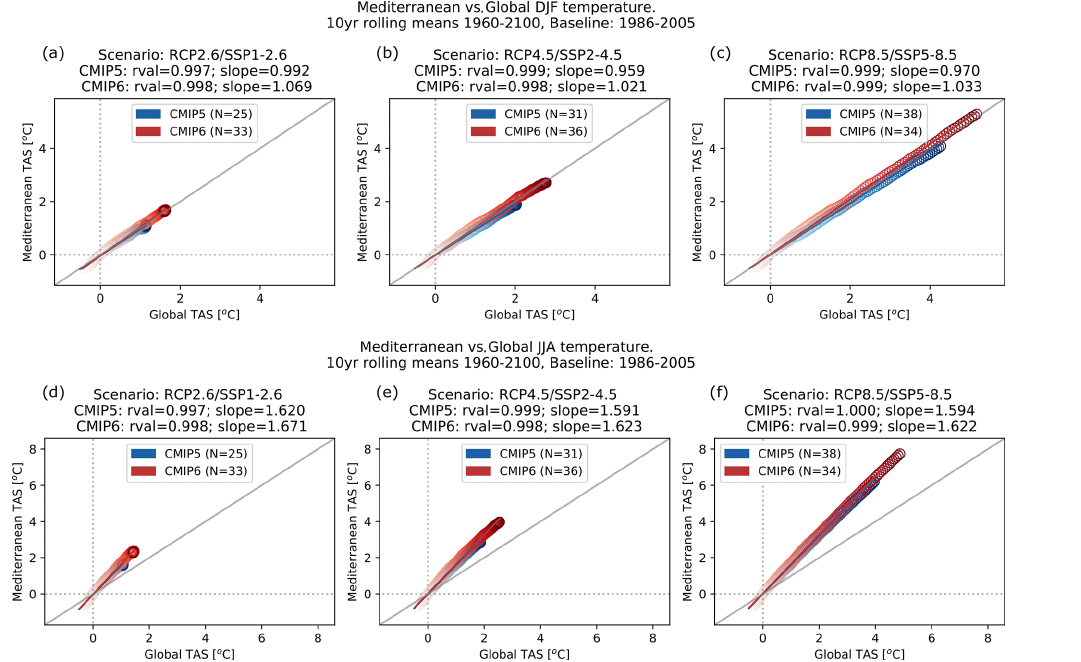
Figure 3. Mediterranean region warming against global warming for the three scenarios (columns) shown in DJF (a–c) and JJA (d–f) for the CMIP5 and CMIP6 ensemble means. Each dot represents a 10 year mean change beginning from 1960–1969 (light colouring) until 2091– 2100 (opaque colouring). The changes are computed with 1986–2005 as baseline. An ordinary least squares linear regression is computed and the slope and r values are shown. N indicates the number of models included in the ensemble